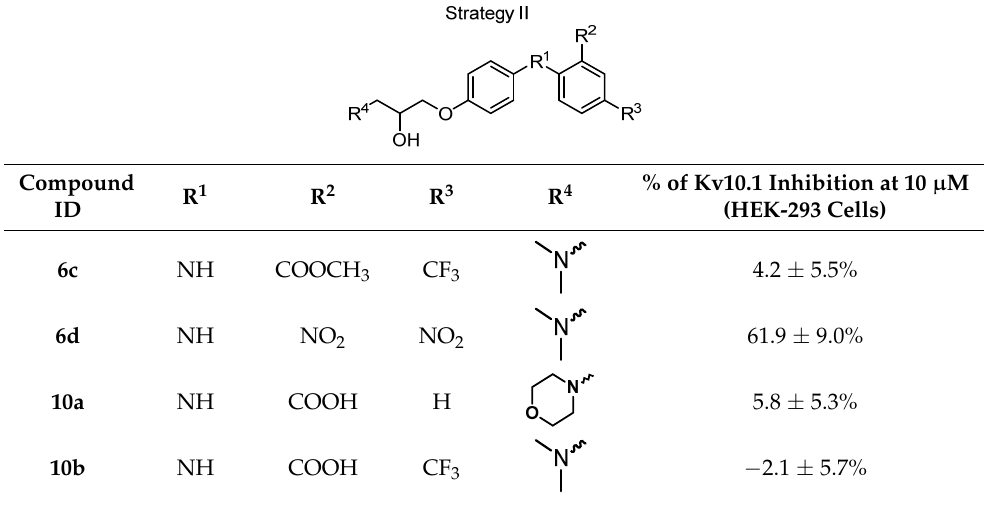
Table 2. Structures and potencies of compounds from Strategy II.